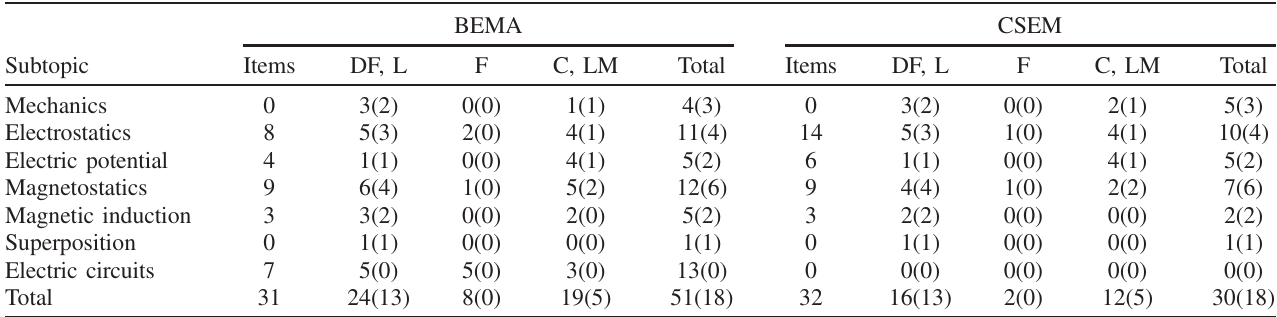
TABLE VII. Comparison of BEMA and CSEM. DF, L, R, C, and LM represent principles in each instrument. The number in parenthesis is the number of the principles also in the other